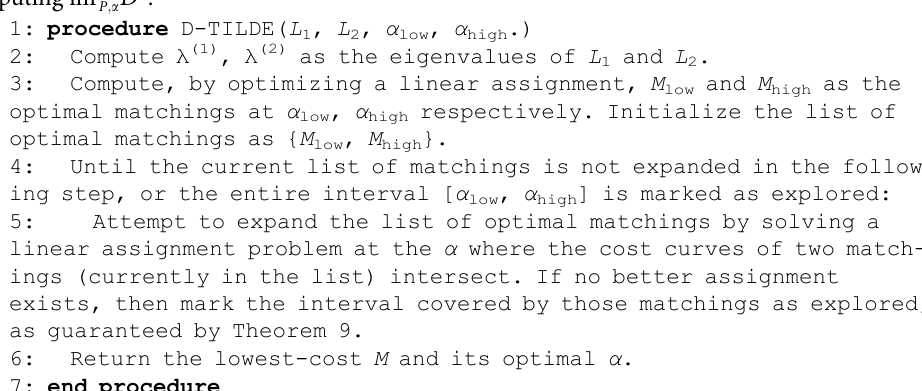
Algorithm 1 Abbreviated pseudocode for the algorithm described in Section 4.1.1, for com- ~ D 2 puting inf P ; a